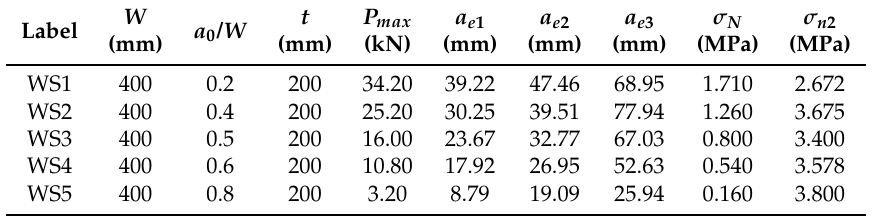
Table 4. Geometry, test results and equivalent crack length of wedge-splitting specimens